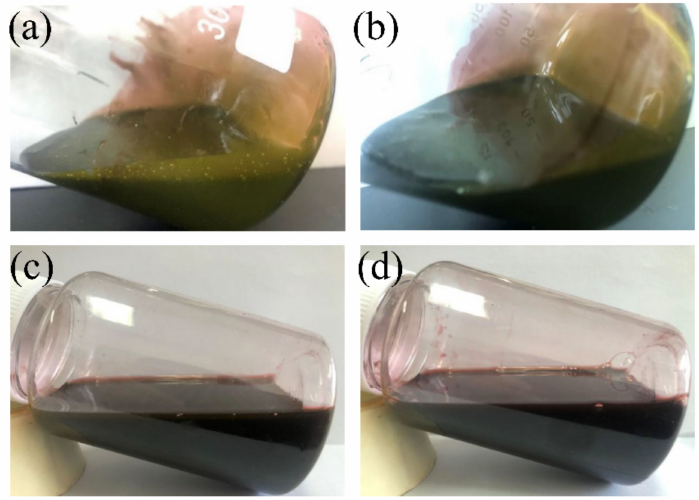
Figure 10. ( a , b ) Photos of PWPU 5000 and PWPU 10,000 with a mass of 10 g dissolved in 80 mL acetone/ethanol ( v / v = 2:1) mixed solvent respectively at 25 ◦ C for 3 h; ( c , d ) Photos of PWPU 5000 and PWPU 10,000 recycled emulsions.